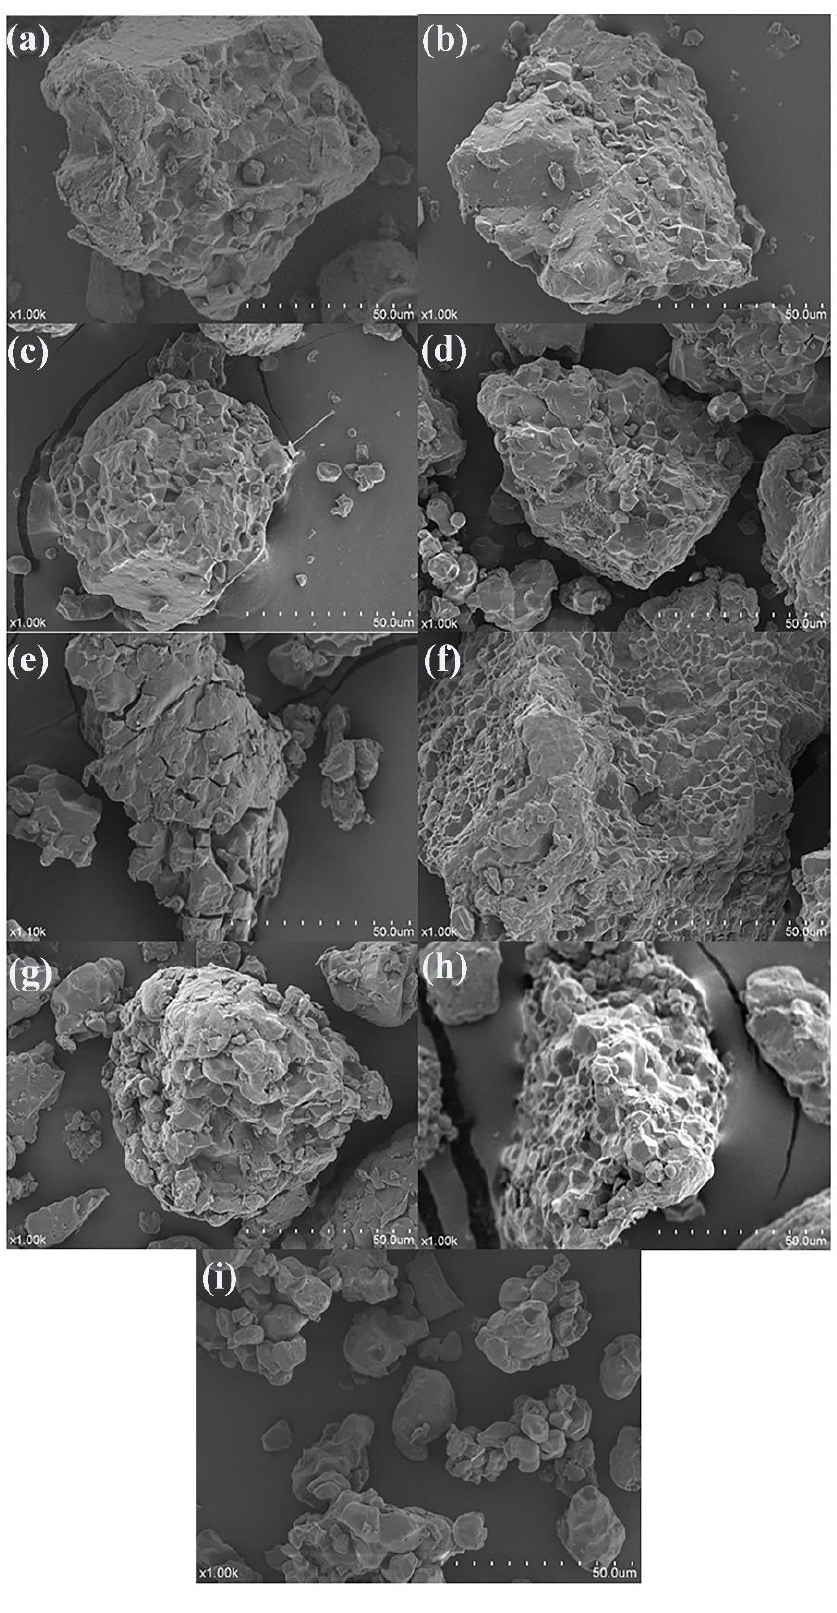
Figure 6. Electron microscopic morphology of the rice samples stored at 20 ◦ C and humidity at 80%: ( a ) 0th day of storage; ( b ) 15th day of storage; ( c ) 20th day of storage; ( d ) 25th day of storage; ( e ) 30th day of storage; ( f ) 35th day of storage; ( g ) 40th day of storage; ( h ) 45th day of storage; ( i ) 50th day of